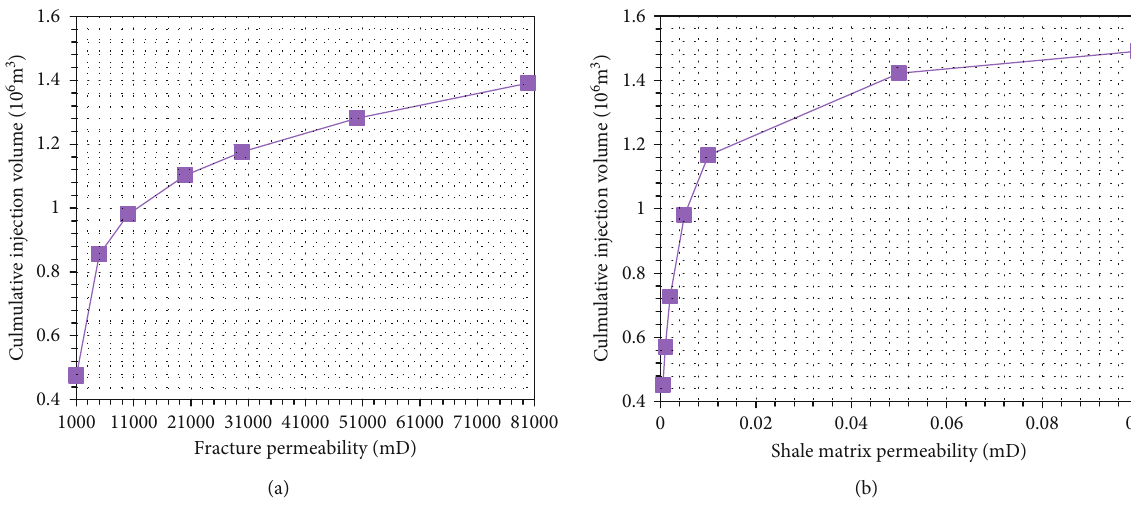
Figure 11: (a) The cumulative injection volume of CO volume of CO injected after 360 days with di ff erent matrix 2